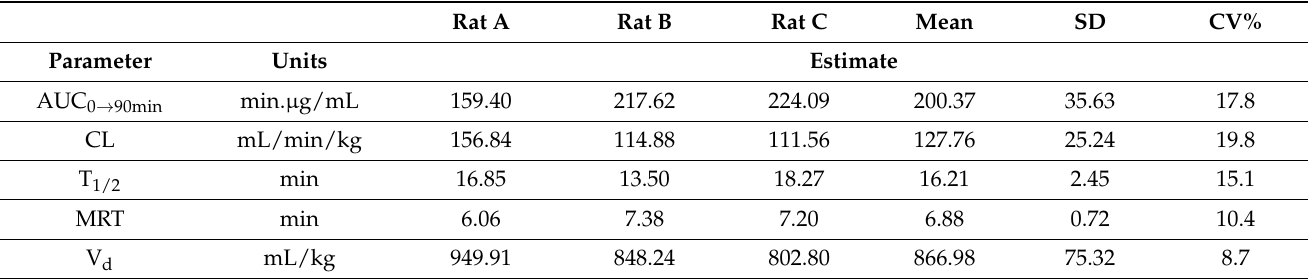
Table 5. Pharmacokinetics parameters of 25 mg/kg BW OXP after intravenous administration to rats ( n = 3).